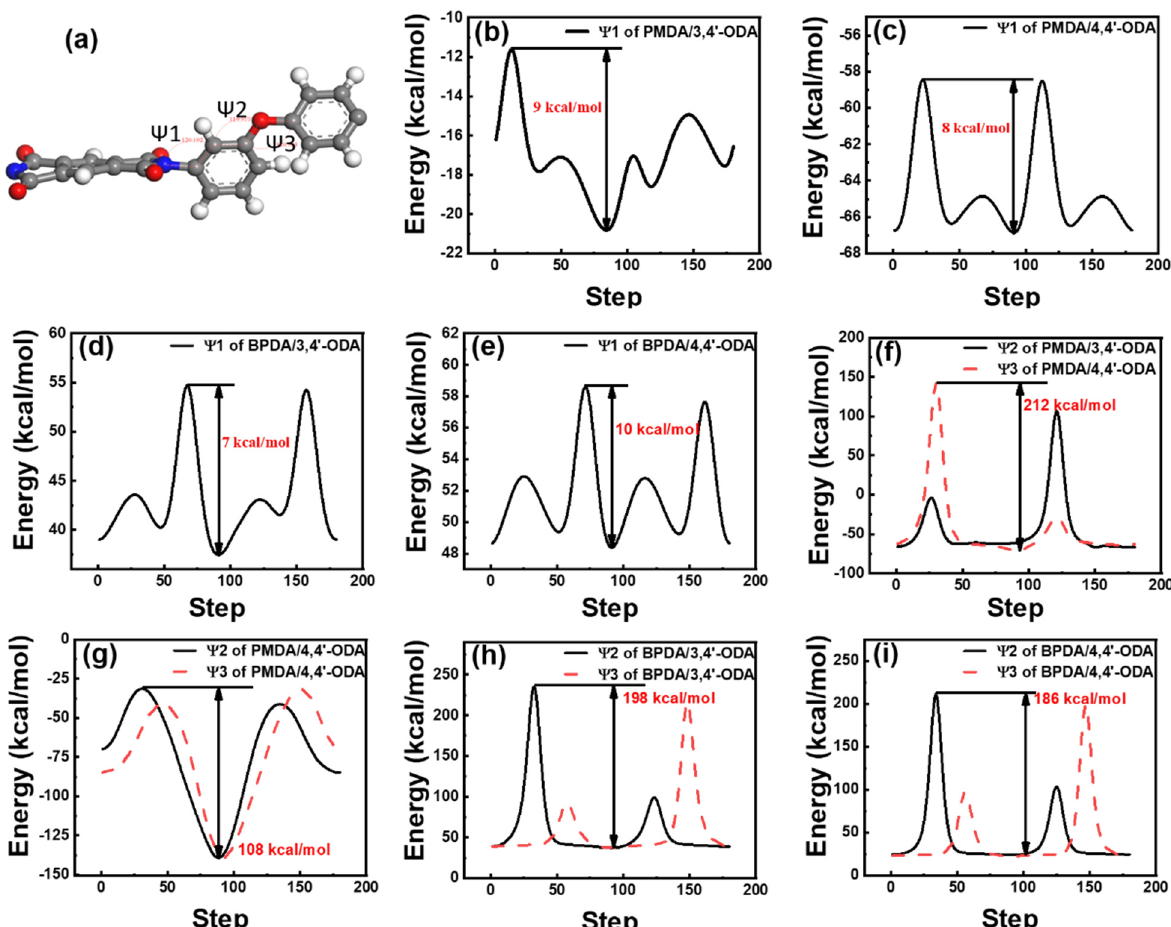
Figure 8. Torsional angular barrier curves of different systems of PI. ( a ) Ψ 1, Ψ 2, Ψ 3 of repeat unit; ( b ) Ψ 1 of PMDA/3,4 ′ -ODA; ( c ) Ψ 2 of PMDA/4,4 ′ -ODA; ( d ) Ψ 1 of BPDA/3,4 ′ -ODA; ( e ) Ψ 1 of BPDA/4,4 ′ -ODA; ( f ) Ψ 2 and Ψ 3 of PMDA/3,4 ′ -ODA; ( g ) Ψ 2 and Ψ 3 of PMDA/4,4 ′ -ODA; ( h ) Ψ 2 and Ψ 3 of BPDA/3,4 ′ -ODA; ( i ) Ψ 2 and Ψ 3 of BPDA/4,4 ′ -ODA.